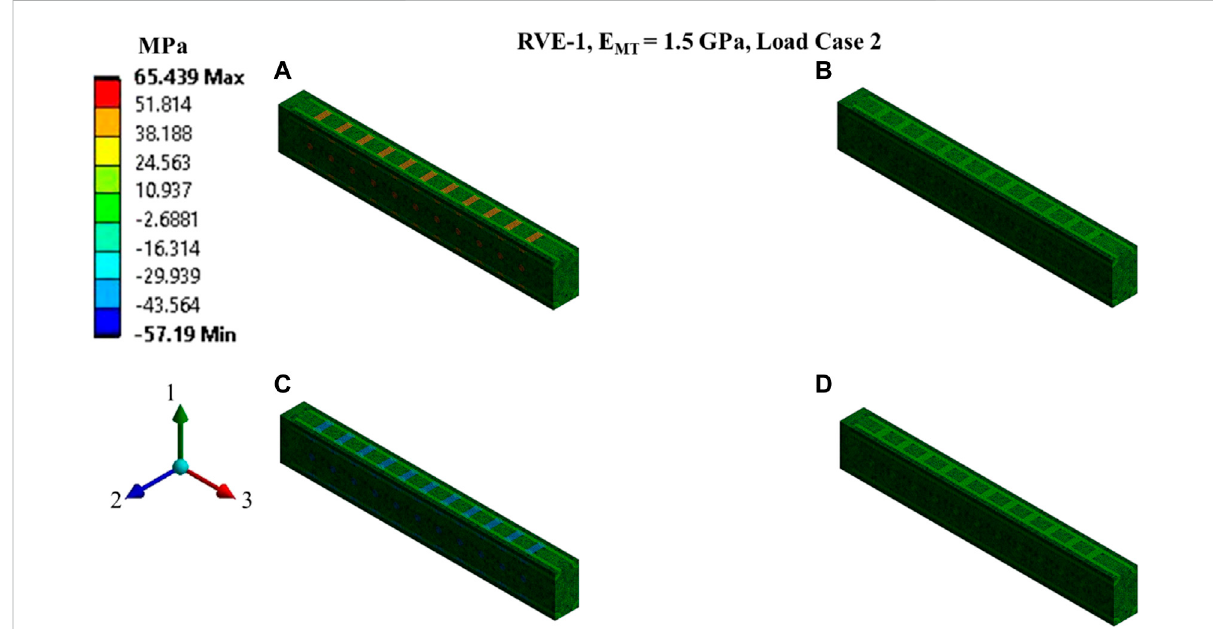
FIGURE 8 Contour plot of the element normal stress in direction 2 ( [ σ 2 ( t )] ρ from Eq. 16). C 12 ( t ) and C 22 ( t ) estimation for the RVE-1 with E MT (cid:2) 1 . 5 GPa by imposing the load case 2. (A) t 1 (cid:2) 3 ms , δ 2 ( t 1 ) (cid:2) 3 nm (B) t 2 (cid:2) 12 ms , δ 2 ( t 2 ) (cid:2) 3 nm (C) t 3 (cid:2) 15 ms , δ 2 ( t 3 ) (cid:2) 0 nm (D) t 4 (cid:2) 40 ms , δ 2 ( t 4 ) (cid:2) 0 nm .